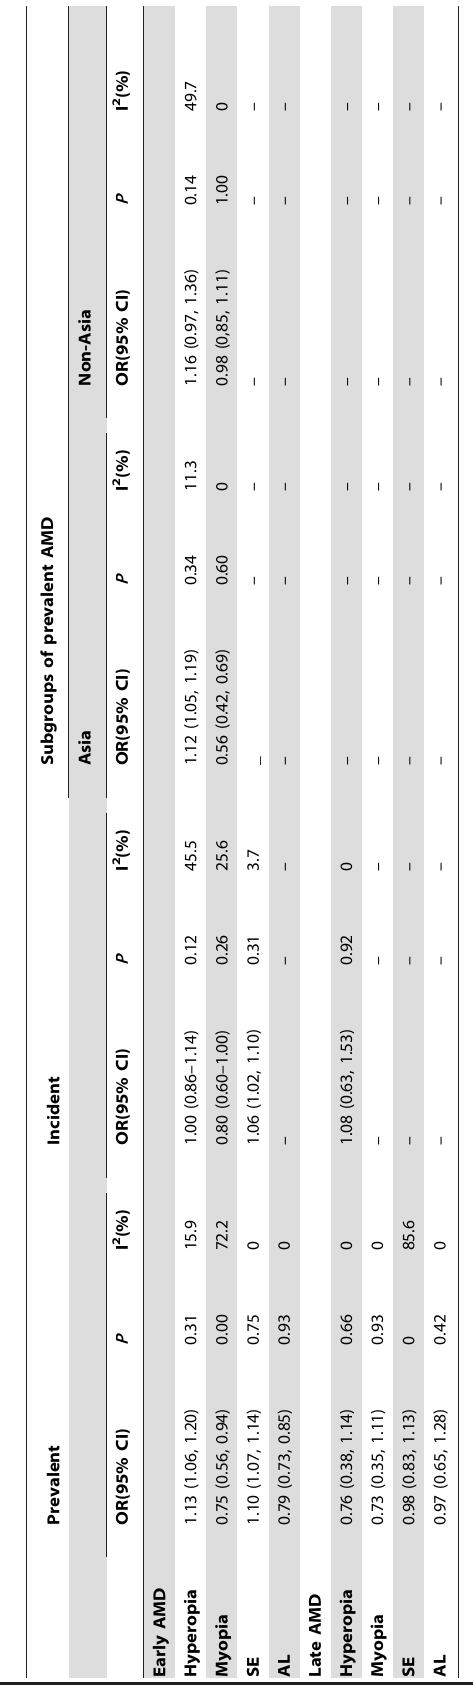
Table S1 lists the characteristics of all systematically reviewed articles and reasons for excluding them from the